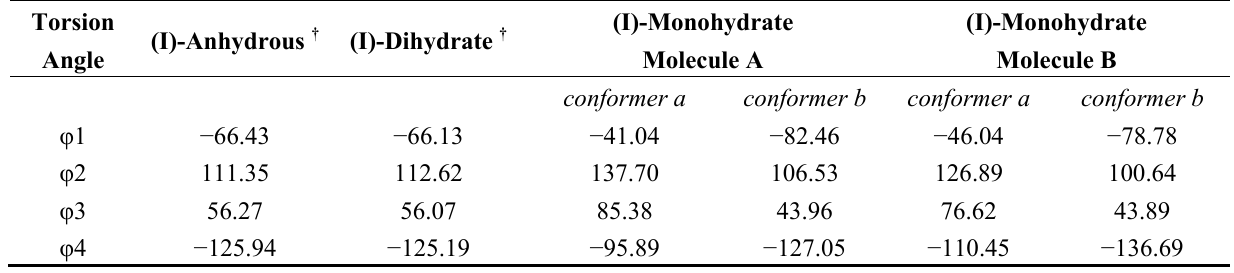
Table 2. Torsion angles (°) about the bonds by which the hydroxyphenyl group links the chroman rings considering all molecules as